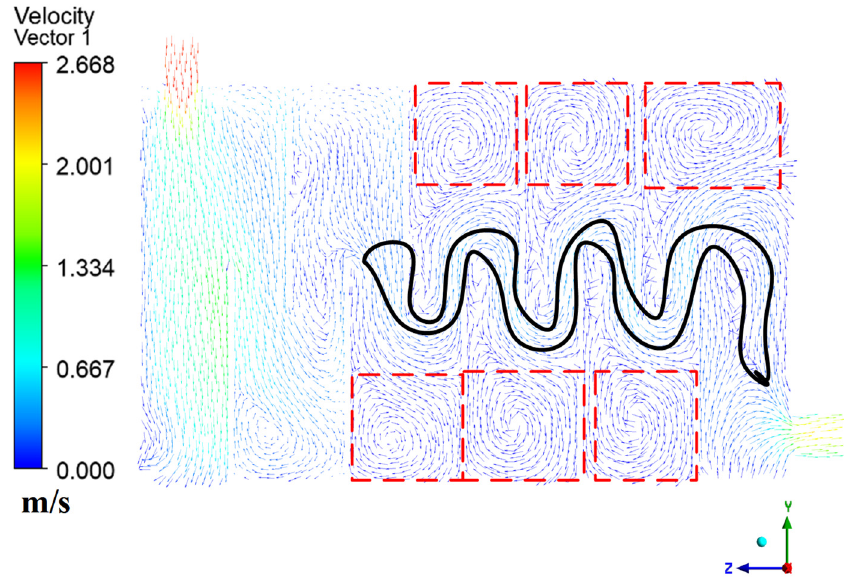
Figure 12. YZ plane velocity vector diagram of the reactor at x = 0.315 m (V = 2.6 m/s, P l = 490 mm, P s = 129.45 mm).